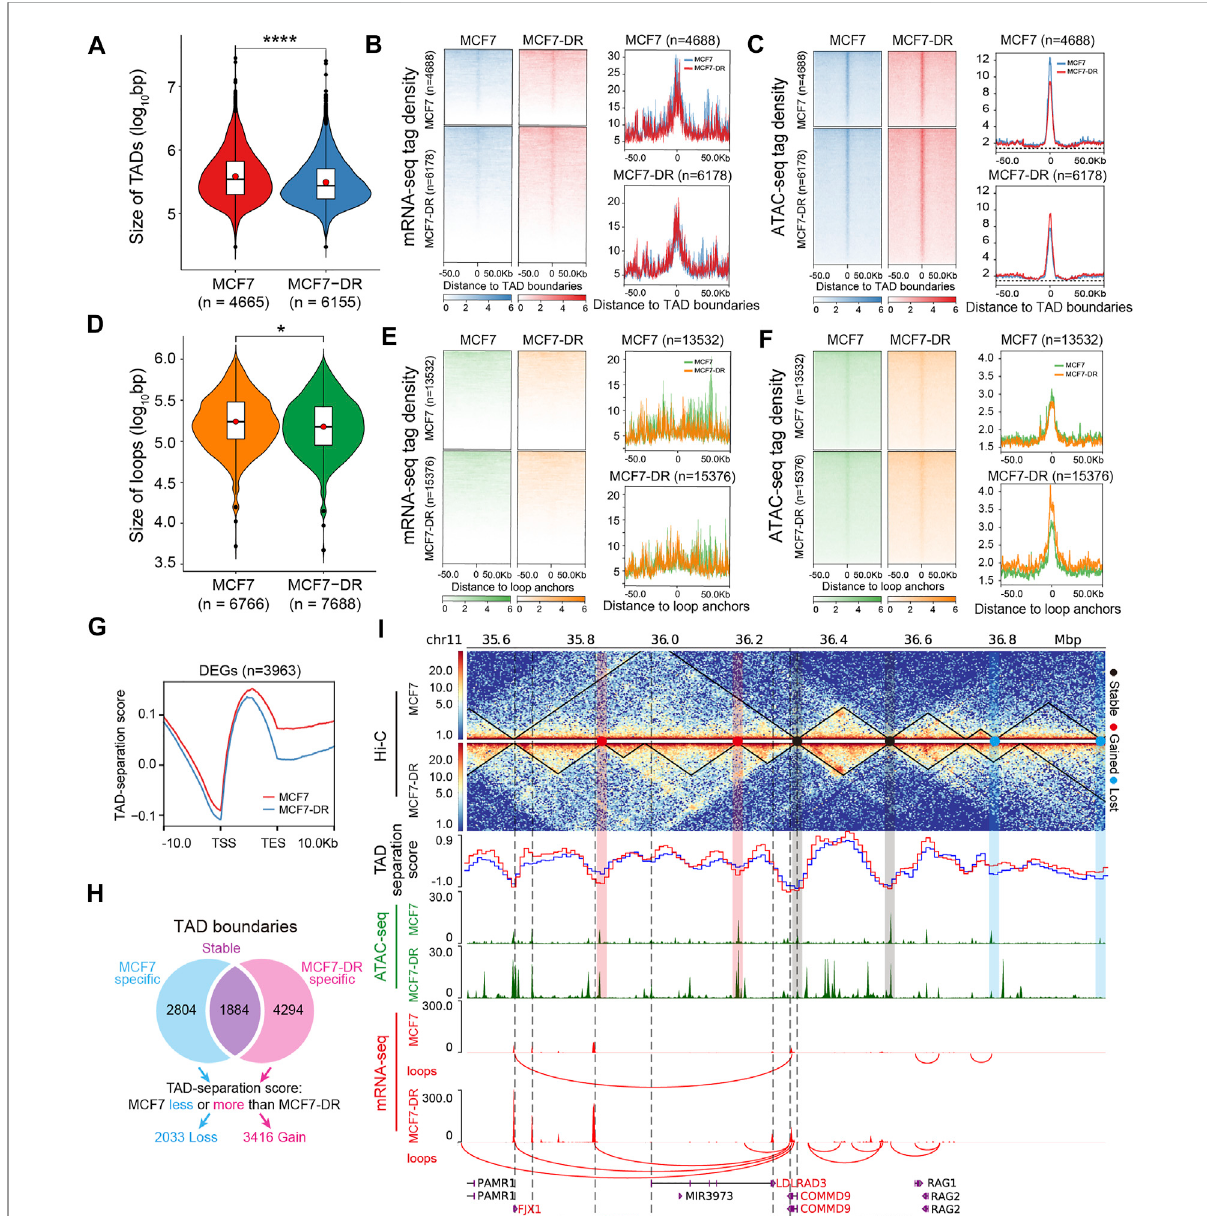
FIGURE 2 Characteristicsandgenome-widechangesinTADsandloops. (A) ViolinplotshowingthesizedistributionofTADsat5-kbresolutionforwhole- genome. The violin plot below shows the number of identi fi ed TADs in MCF7 ( n = 4665) and MCF7-DR ( n = 6155) cells. p values were calculated by Wilcoxon rank-sum test in R software, **** p < 0.0001. (B,C) Heatmaps and average pro fi les displaying normalized tag density (RPKM) of mRNA-seq (B) and ATAC-seq (C) data over the identi fi ed TAD boundaries across a genomic window -50 kb upstream and +50 kb downstream from the center of TAD boundaries in MCF7 and MCF7-DR cells. The top panels show read signals over the 4688 TAD boundaries identi fi ed in MCF7 cells and the bottom panels show read signals over the 6178 TAD boundaries identi fi ed in MCF7-DR cells. (D) Violin plot showing the size distribution of chromatin loops at 5-kb resolution for the whole genome. The number of identi fi ed loops in MCF7 ( n = 6766) and MCF7-DR ( n = 7688) cells is displayed below the violin plot. p values were calculated by Wilcoxon rank-sum test in R software, * p < 0.05. (E,F) Heatmaps and average pro fi les displaying normalized tag density (RPKM) of mRNA-seq (E) and ATAC-seq (F) data located within 50 kb upstream and downstream of the center of loop anchors in MCF7 and MCF7-DR cells. The top panels show read signals over the 13532 loop anchors identi fi ed in MCF7 cells and the bottom panelsshowreadsignalsoverthe15376loopanchorsidenti fi edinMCF7-DRcells. (G) Apro fi leoftheaverageTAD-separationscoresacrossthegene bodyandthe10 kbupstreamofTSSand10 kbdownstreamofTESofallDEGs. (H) Aschematic fl owdiagramshowingtheidenti fi cationofgained,lost or stable TAD boundaries. The gained TAD boundaries are MCF7-DR speci fi c and possess lower TAD-separation scores compared to the parental cells. The lost TAD boundaries were associated with a higher TAD-separation score (i.e., lower insulation strength) in MCF7-DR cells and were only detected in MCF7 cells; the boundaries detected in both MCF7 and MCF7-DR cells were de fi ned as stable TAD boundaries. (I) A